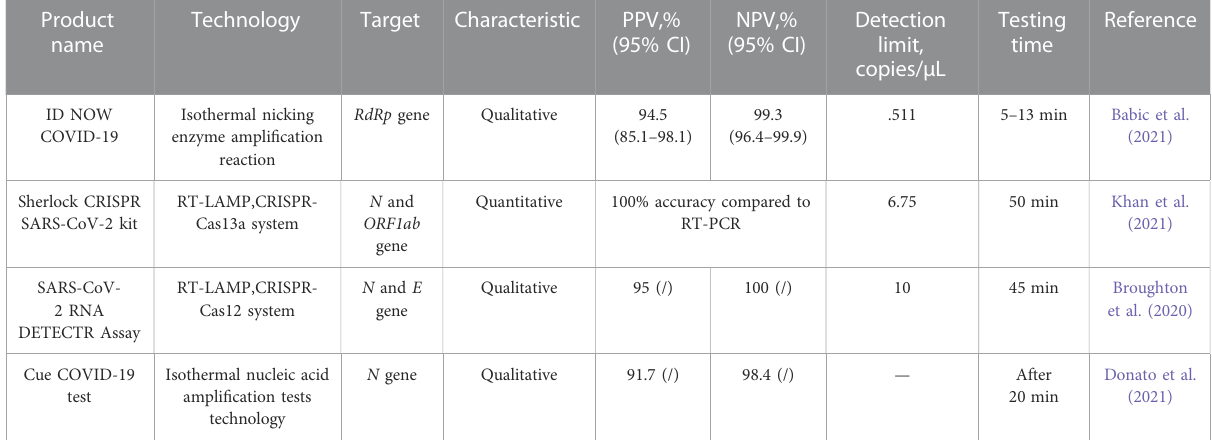
TABLE 2 Comparison of the performance of some of the LFIC test strips authorized for nucleic acid (2022c) by the U.S. Food and Drug Administration emergency